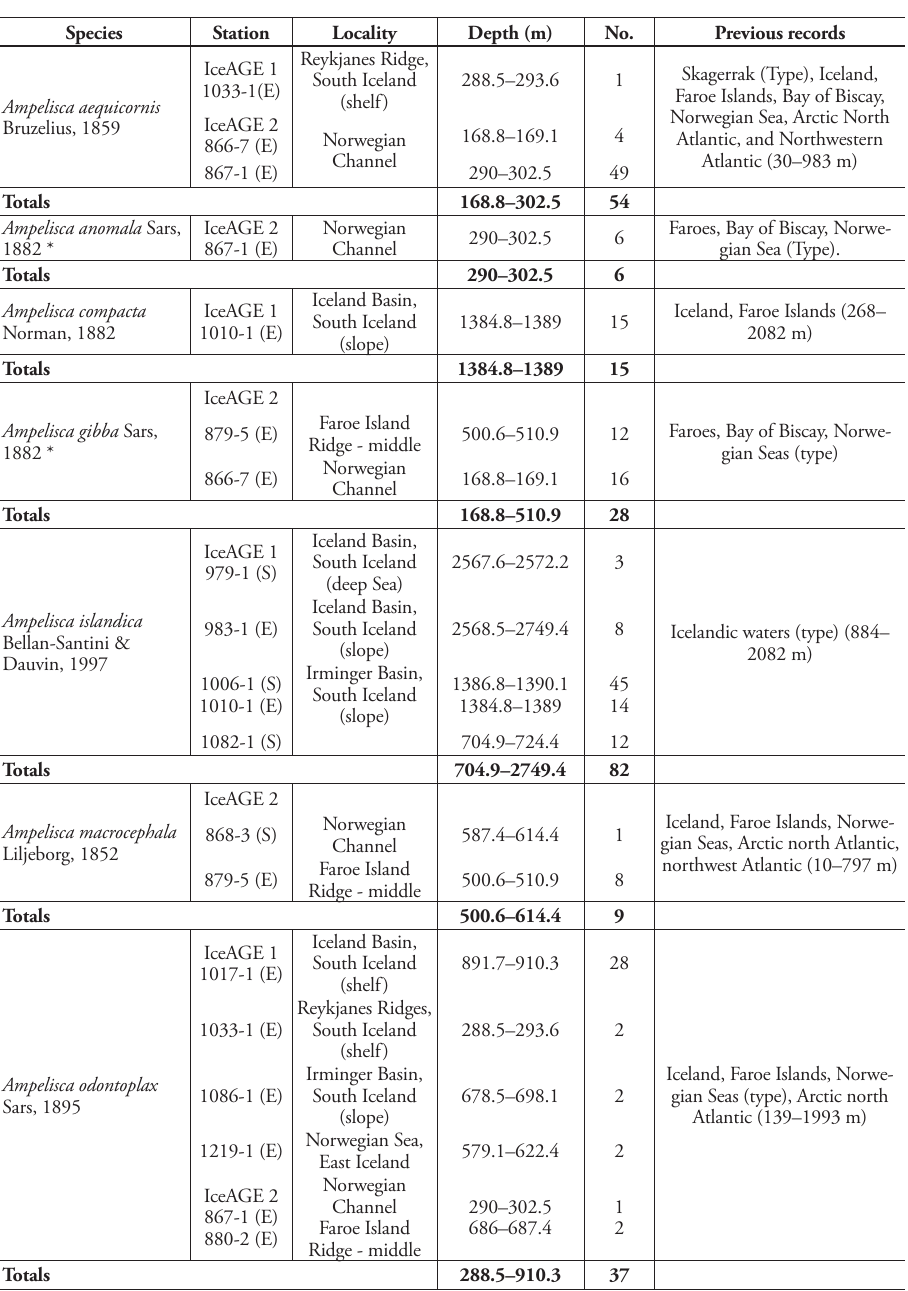
Table 1. Ampeliscidae amphipods from IceAGE 1 and IceAGE 2 epibenthic sledge collections. (E) rep- resents samples from the epinet bucket of the epibenthic sledge; (EÜ) represents samples from the epinet above the bucket; (S) represents samples from the supranet bucket; and (SÜ) represent samples from the supranet above the